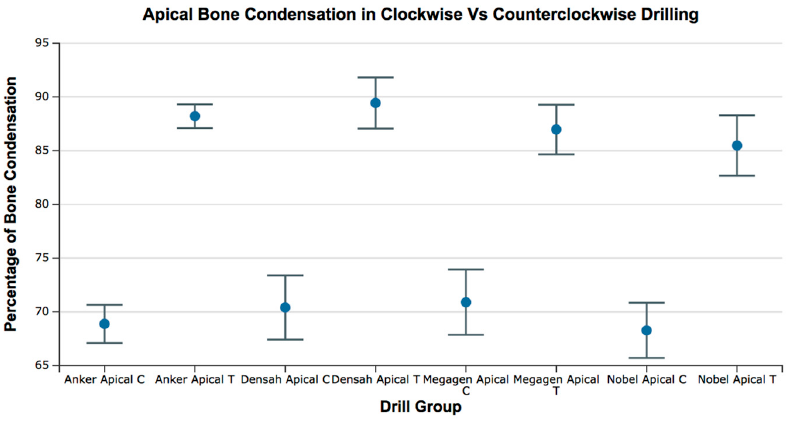
Figure 11. Box plot for the percentage of bone condensation at the apical area for all groups. C =